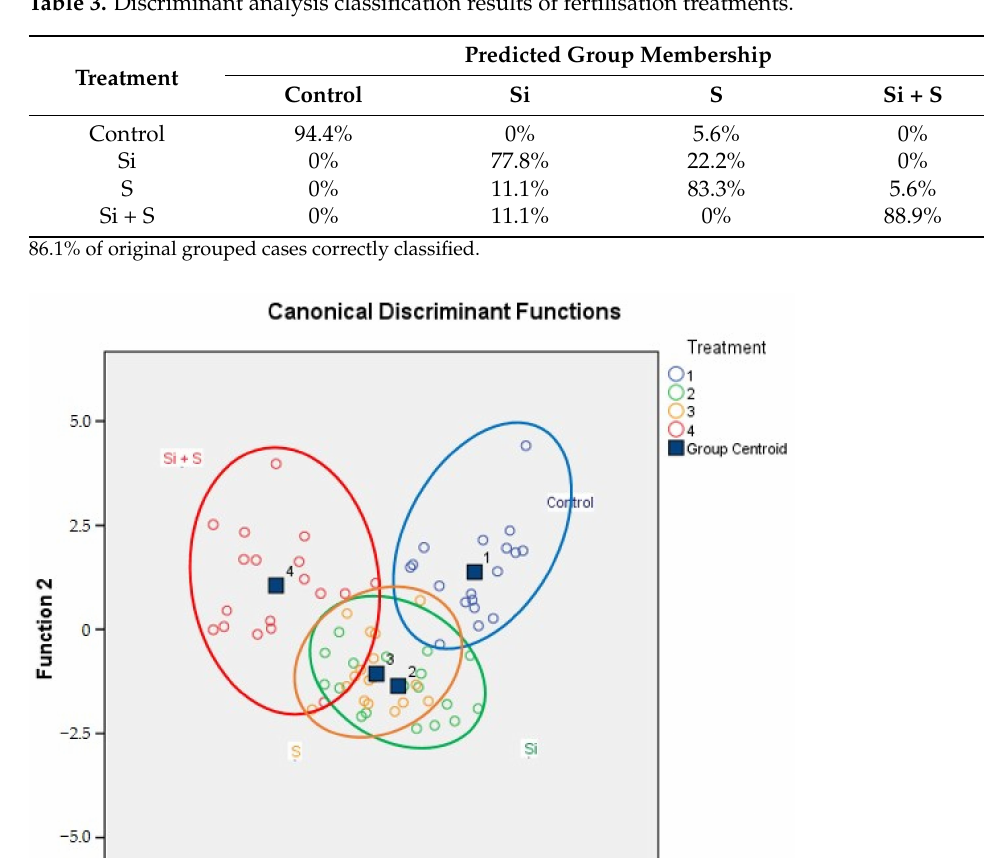
Table 3. Discriminant analysis classification results of fertilisation treatments.